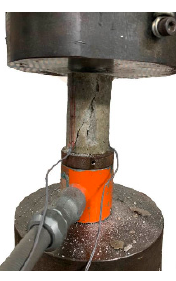
Figure 3. Test setup for determining the modulus of elasticity.